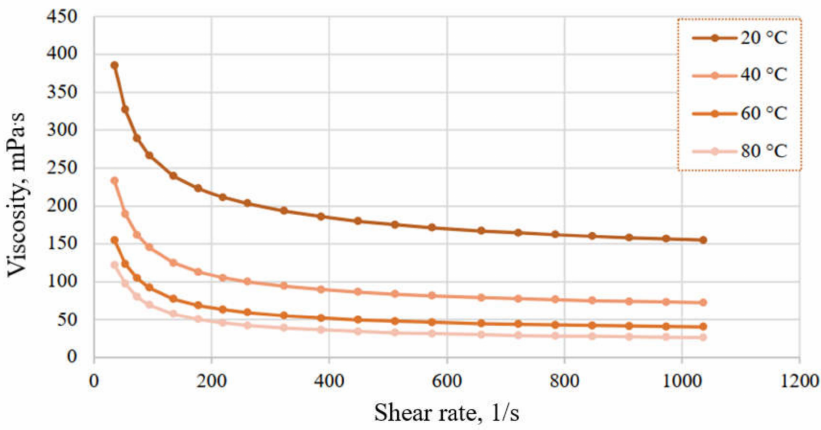
Figure 5. Dependence of viscosity on the shear rate for the hydrocarbon-based drilling mud at different